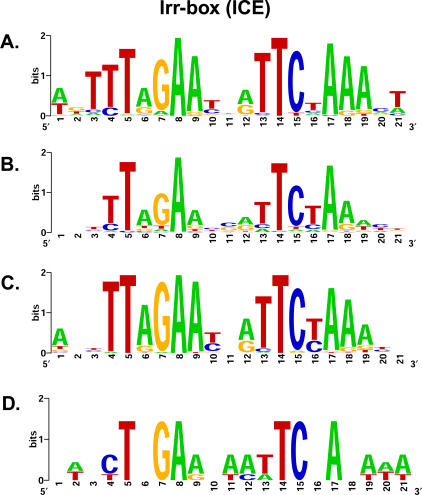
Sequence Logos for the Predicted Irr Recognition Motifs (ICEs) in Various Groups of α-Proteobacteria(A) Rhizobiaceae plus Mesorhizobium, Brucella, and Bartonella species.(B) Bradyrhizobiaceae group.(C) Rhodobacteraceae group.(D) Rhodospirillales group.